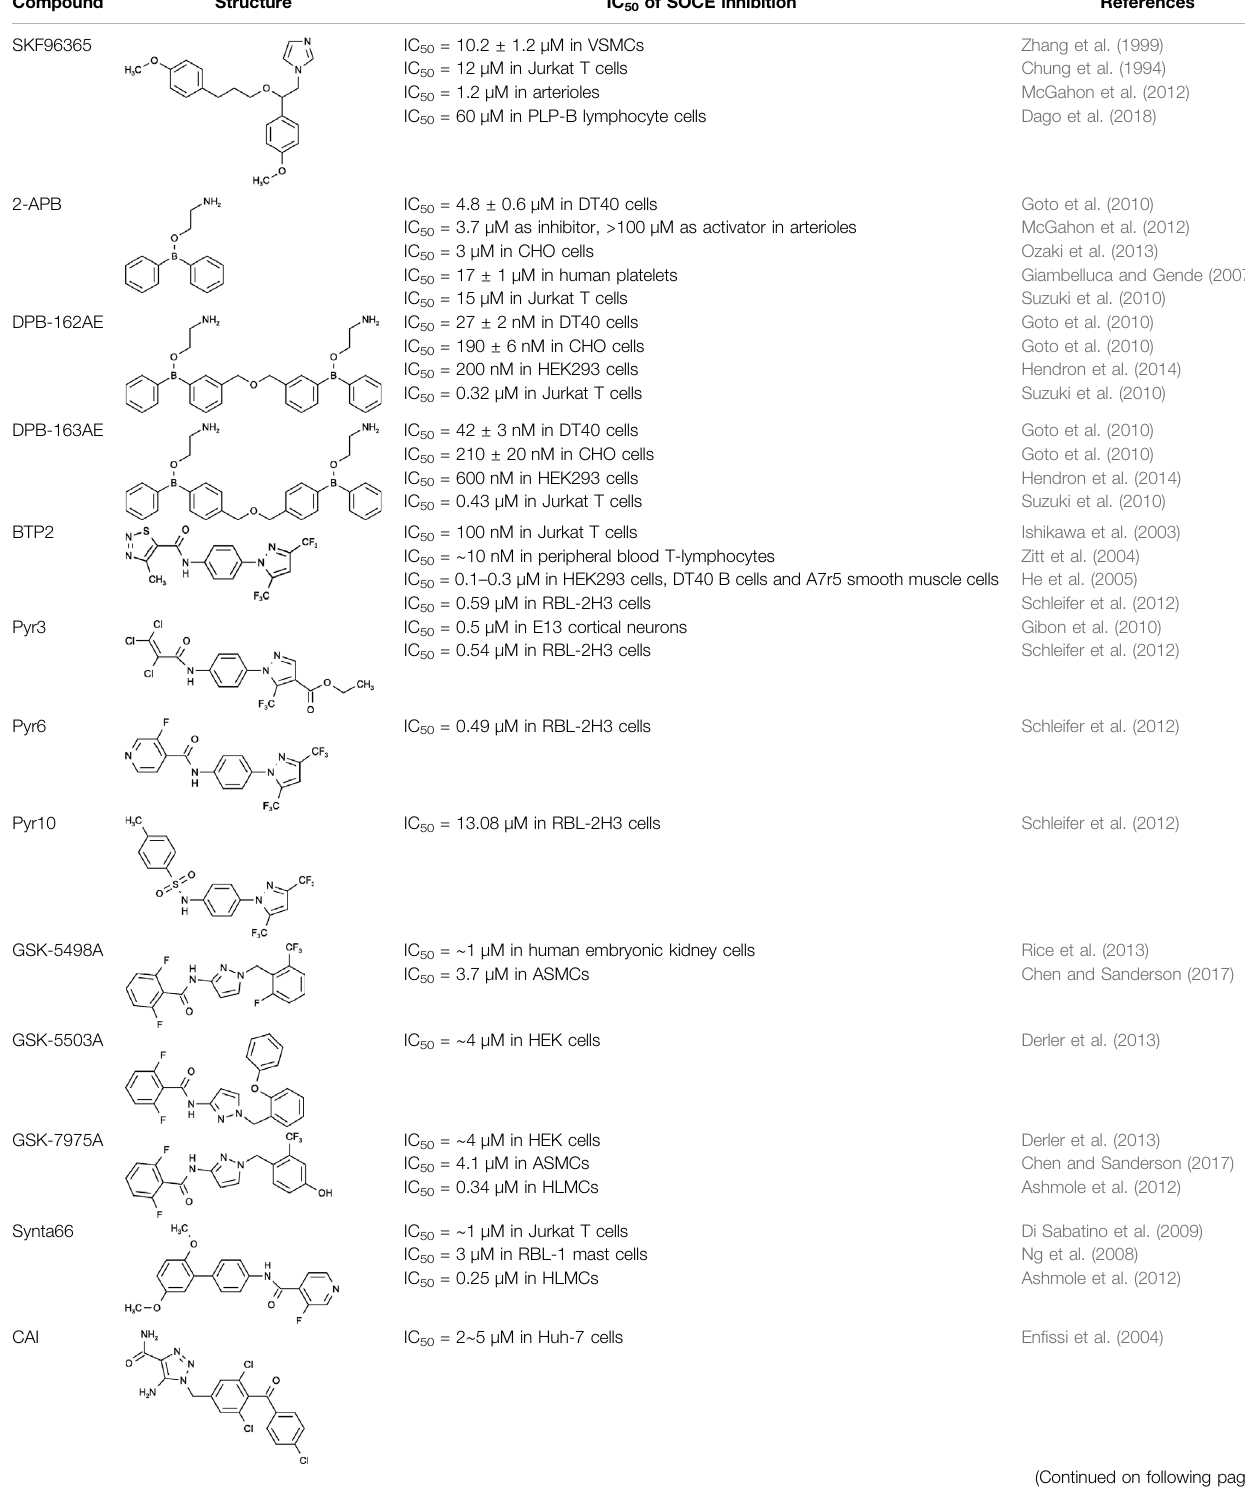
TABLE 1 | Structures and IC 50 of